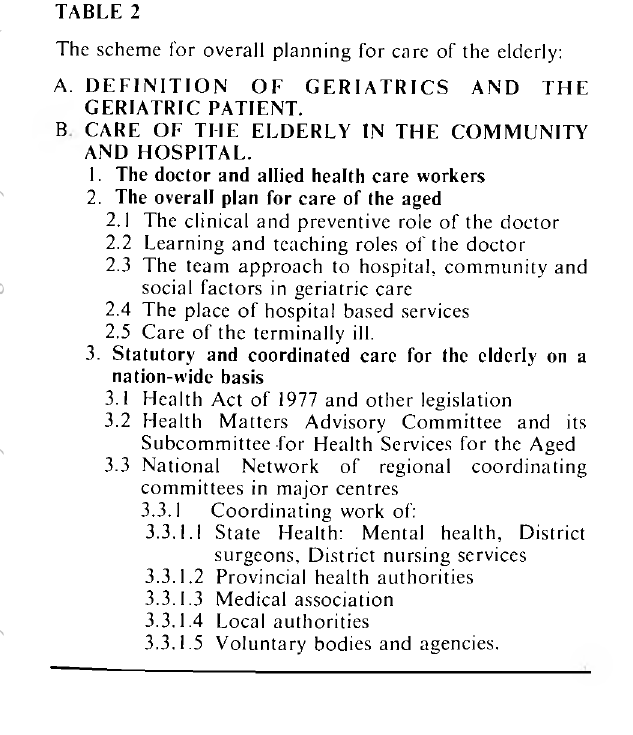
Percentage population 65 and over, 1970 and projected in year